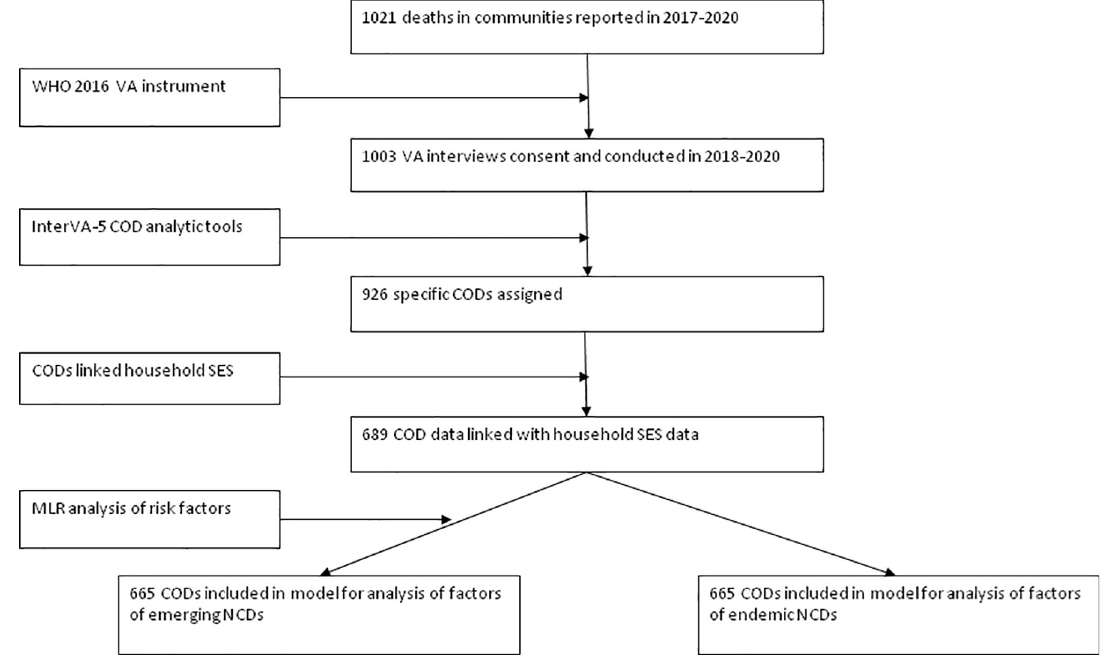
Fig 1. Flow chart for identification of deaths, selection for interview, and analyses of sociodemographic factors of mortalities from emerging and endemic NCDs in the population in PNG, PNGIMR’s CHESS, 2020.